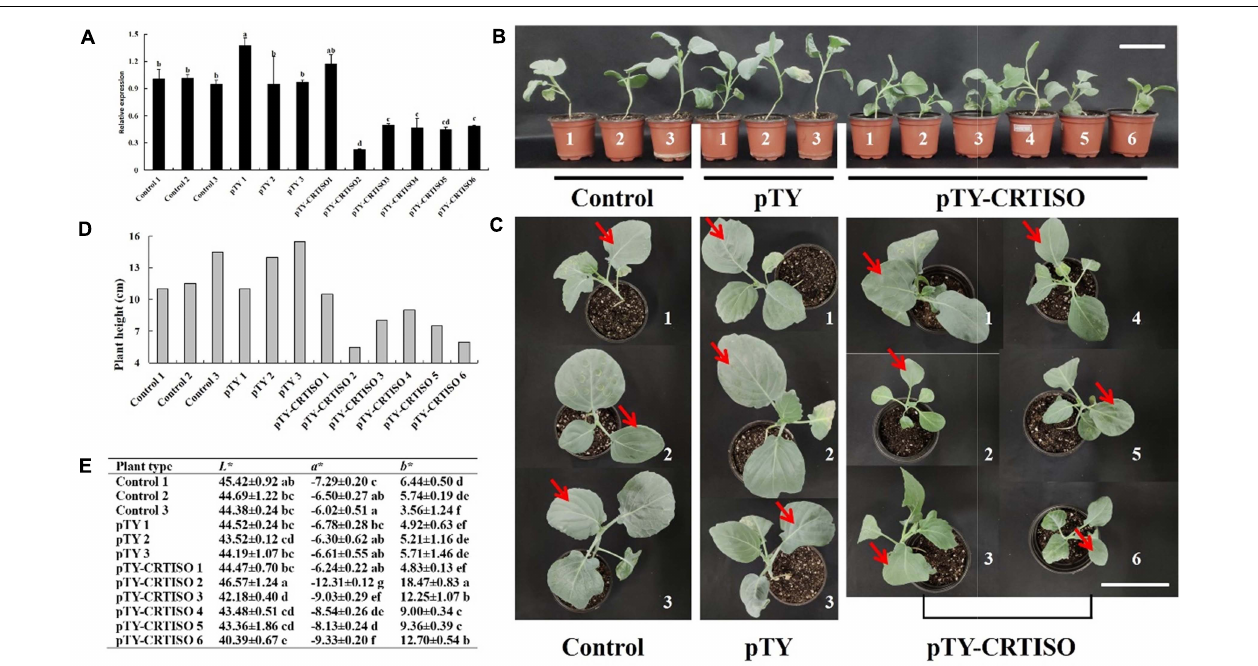
FIGURE 4 | BoaCRTISO silencing affects the color and growth of Chinese kale. (A) Expressions of BoaCRTISO in control, pTY, and pTY-BoaCRTISO plants. Data are expressed as mean ± standard deviation. The same letter indicates that there is no significant difference between the values tested by least significant difference (LSD) ( p < 0.05). (B) Front view of control, pTY, and pTY-BoaCRTISO plants. Bar = 10 cm. (C) Top view of control, pTY, and pTY-BoaCRTISO plants. The red arrow points to the sampled leaves. Bar = 10 cm. (D) Plant heights of control, pTY, and pTY-BoaCRTISO plants at 1 week after the last infiltration. (E) The color parameters of control, pTY, and pTY-BoaCRTISO plants at 1 week after the last infiltration. Data are expressed as a mean ± SD. The same letter in the same column means no significant differences among values ( p < 0.05) according to a least significant difference (LSD)